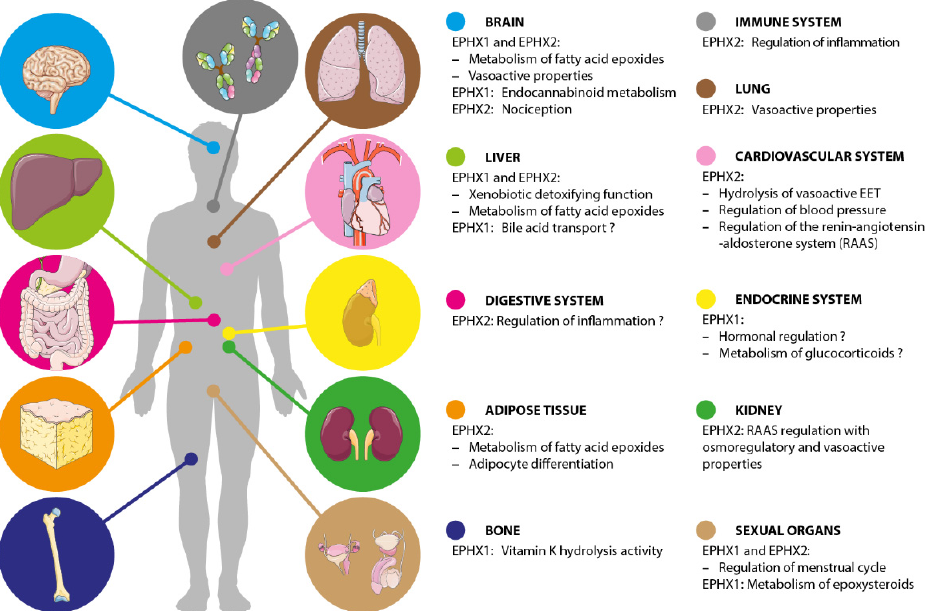
Figure 2. Kaleidoscopic view of the main functions of EPHX1 and EPHX2. Some biological functions remain hypothetical as the associated findings are not yet replicated or need further investigations.